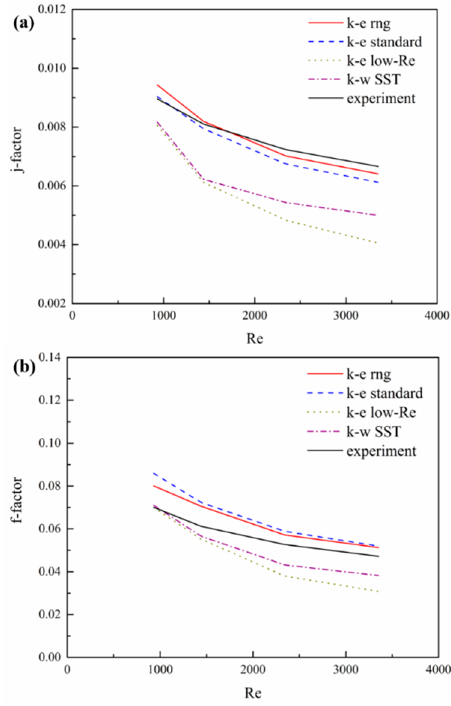
Figure 4. Comparison between the values of the ( a ) j -factor and ( b ) f -factor using different turbulent flow models.